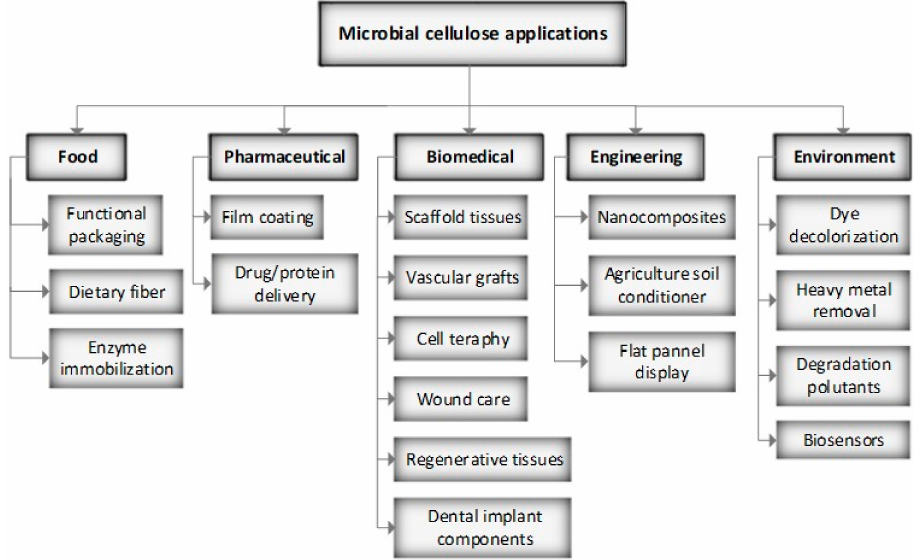
Figure 7. Di ff erent application fields of microbial cellulose. Adapted from Hussain et al.